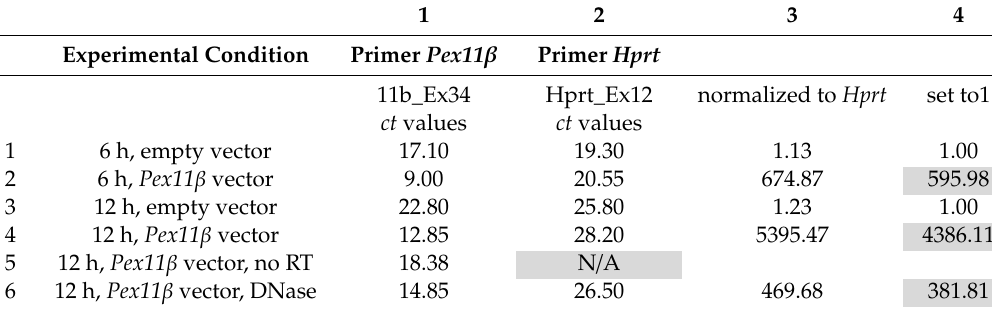
Table 3. After transfection with a Pex11 β cDNA-containing expression vector, we measured extremely high increases in the level of the Pex11 β PCR product using the exon 3–4 spanning primer (11b_Ex34, highlighted in gray). We hypothesized an amplification of the residual plasmid DNA, because DNase I treatment reduced the Pex11 β PCR product level (column 4, lines 4 vs. 6) and genomic DNA will not be amplified with the 11b_Ex34 PCR primer. Cells were either treated with the transfection reagent only (no transfection), or transfected with an empty vector (empty vector) or a Pex11 β cDNA expression vector ( Pex11 β vector) for 6 h and 12 h. Except for cells transfected with the Pex11 β vector for 12 h, all RNA samples were subjected to random RT and PCR, without further DNase I treatment. In cells transfected with the Pex11 β vector for 12 h, the same RNA was subdivided and either underwent no RT plus no DNase I treatment (line 5), or random RT, with (line 6) or without (line 4) a prior DNase I treatment. Ct values of the Pex11 β and Hprt PCR products are given in columns 1 and 2, respectively. Data on the Pex11 β PCR product were normalized to Hprt as the reference gene (column 3) and then related to non-transfected cells (calculation based on Equation (1)); the normalized PCR product level of non-transfected cells was set to 1 (column